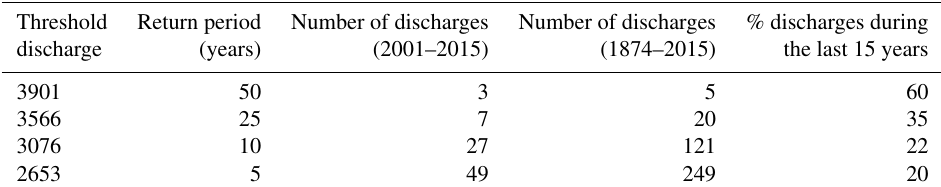
Table 2. Number of daily discharges (m 3 s − 1 ) above a threshold, for two time periods: discharges within the last 15 years (since 2001) vs. discharges during the entire period (1874–2015). The highest threshold is 50 years, and the lowest is 5 years. The discharge thresholds are based on return periods for 5-, 10-, 25- and 50-year storms. For example, any storm with discharge higher than 3901m 3 s − 1 is a 50-year storm.